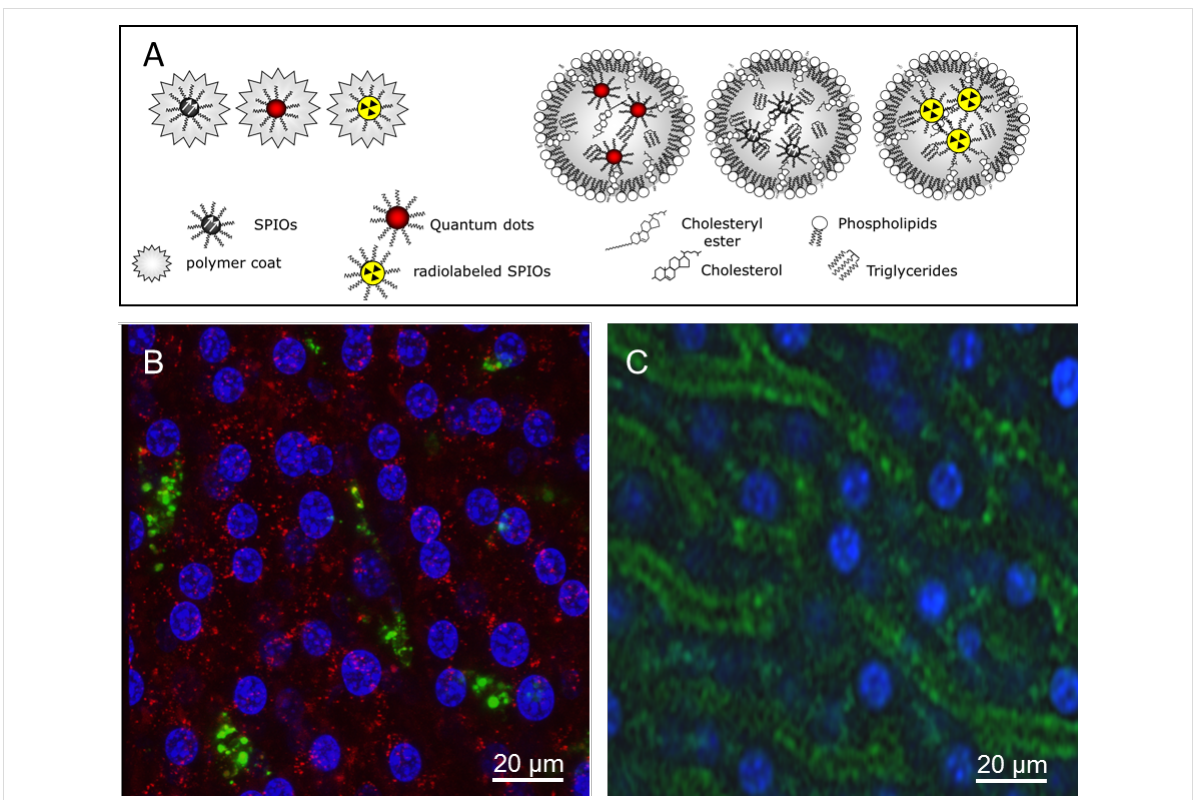
Figure 1: Characterization of nanocrystals and uptake into liver cells in vivo. (A) Oleic acid-stabilized SPIOs, radiolabeled SPIOs (59Fe-SPIOs) or QDs are embedded in PMAOD-polymer or in lipid micelles as indicated in the model. (B) Native DID-labeled LDL (red) and QDs-micelles (green) or (C) polymer-embedded QDs (green) were injected into wild type C57BL/6 mice via a tail vein catheter. Nuclei were stained by intraperitoneal injection of the fluorescence dye Hoechst 33342. 30 min after injection, the liver was excised and directly placed on the confocal microscope. As shown in (B), LDL are internalized by hepatocytes (red) whereas signals from QDs embedded within lipid micelles are found associated with hepatic Kupffer cells (green). (C) shows that polymer-embedded QDs are primarily associated with endothelial cells lining the sinusoids of the liver. Scale bars = 20